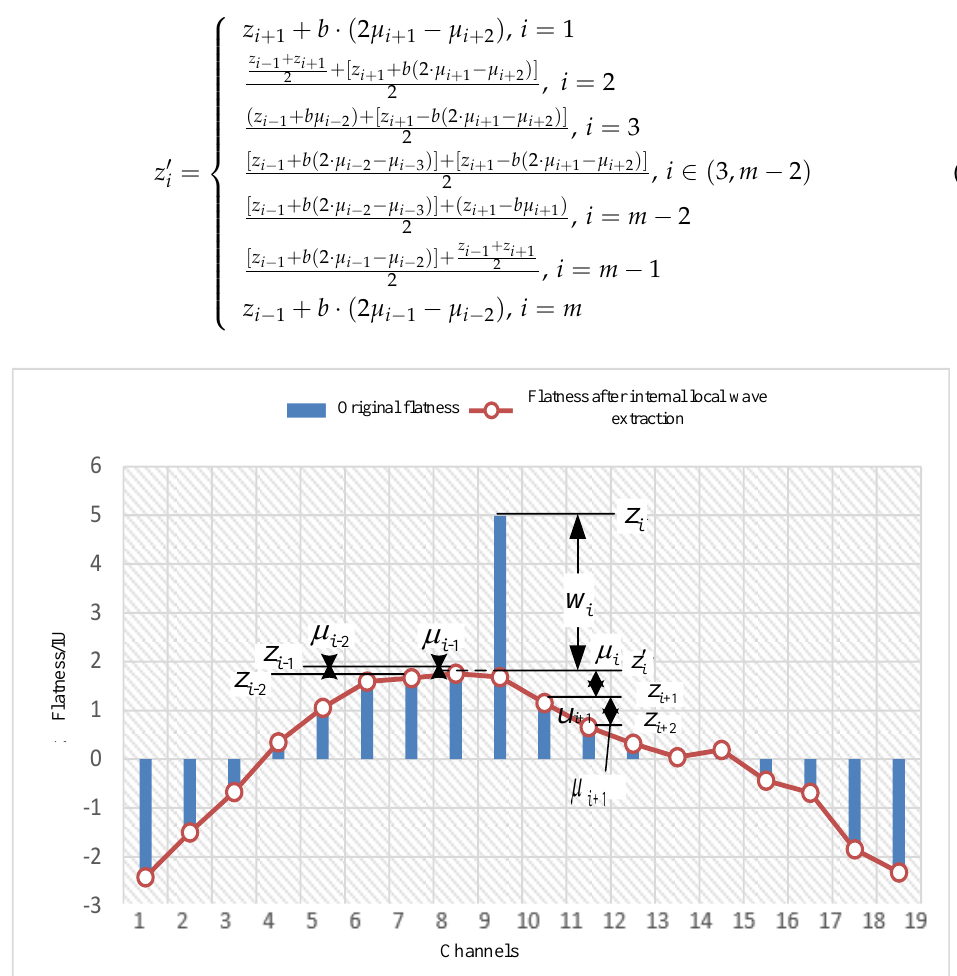
Figure 6. Principle of the internal local wave shape defect recognition and extraction.